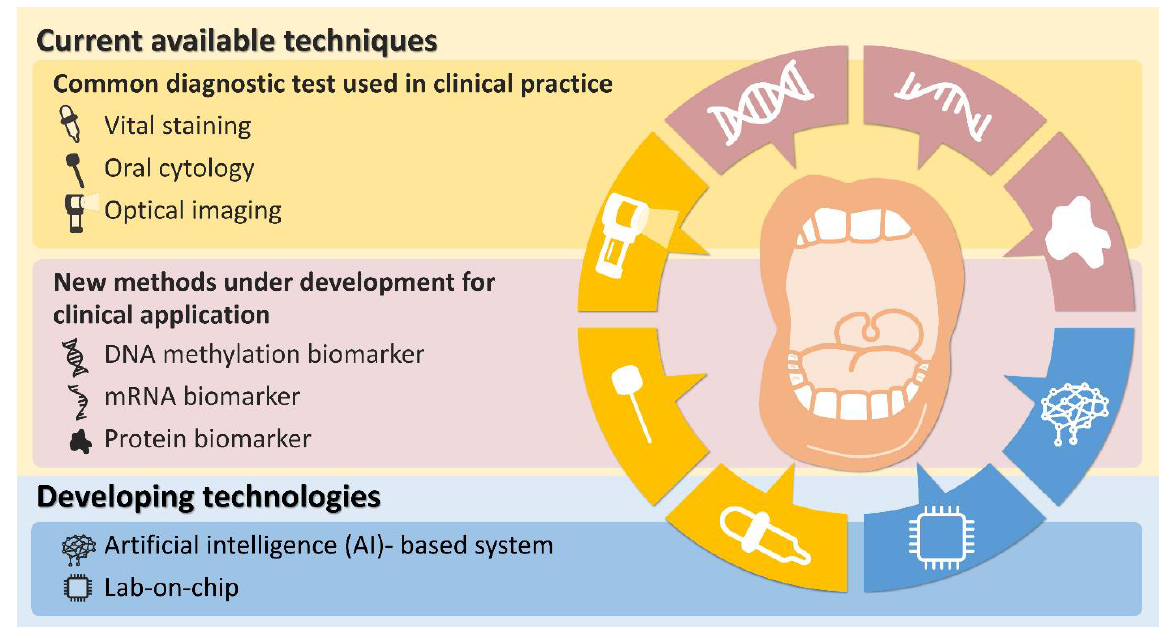
Figure 1. Schematic of a wide spectrum of currently available early diagnostic techniques and developing technologies for detecting oral premalignant disorders and oral cancer. The figure was created by Yi-Ju Chen for this article. Copyright © 2021 by iStat Biomedical Co., Ltd.